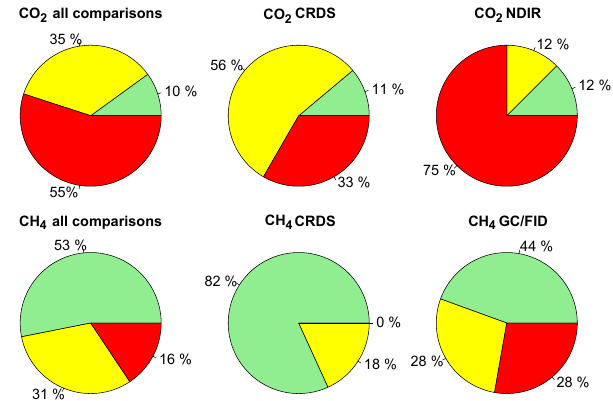
Figure 17. Upper panel: percentage of CO 2 performance audit re- sults that were within the WMO/GAW compatibility goals in the range from 360 to 450ppm (green), the extended compatibility goals (yellow), or outside the compatibility goals (red area). Results for all, but only CRDS and NDIR comparisons are shown. Lower panel: same for CH 4 in the range of 1700–2100ppb; for all, but only CRDS and GC/FID